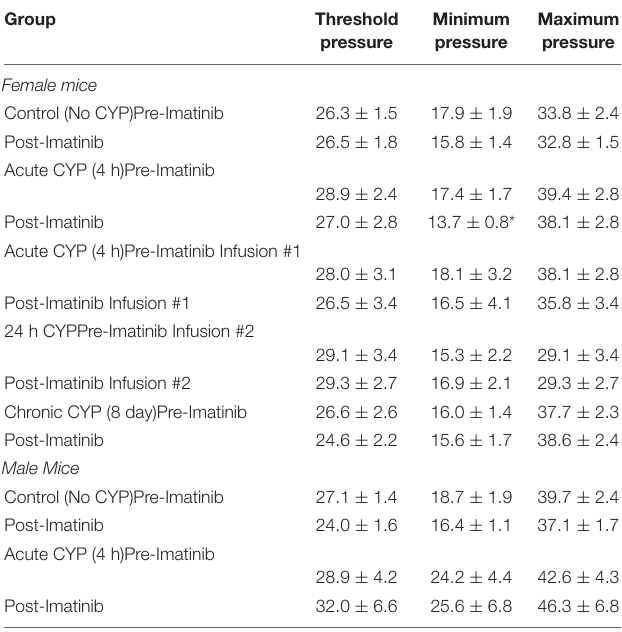
TABLE 2 | Mean bladder pressures during conscious, open-outlet cystometry in control (no CYP), acute CYP (4 h or 24 h, 200 mg/kg, i.p.), or chronic CYP (75 mg/kg every 72 h for 8 days, i.p.) male and female mice treated with imatinib mesylate or vehicle (saline) via intravesical bladder infusion.